Question: What does this figure show? Answer in one sentence.
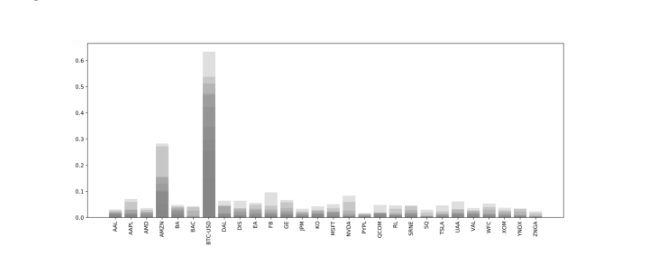
Answer: Performance of auto-encoder Model